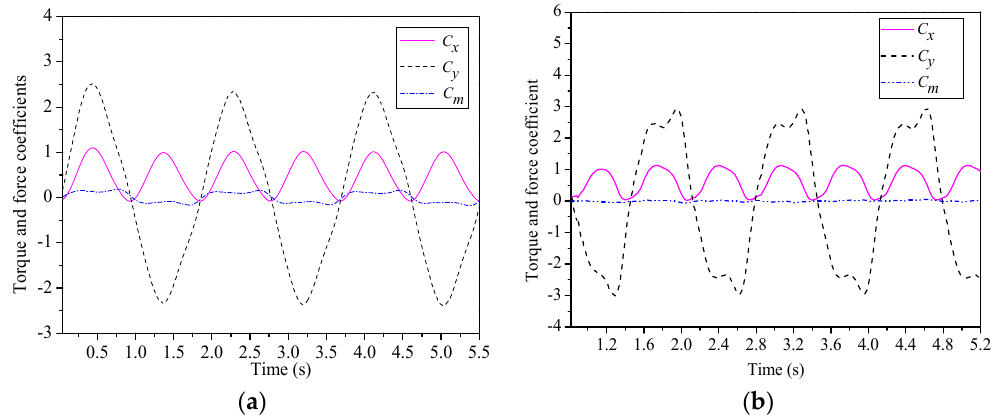
Figure 10. Forces and torque curves: ( a ) NACA foil; ( b ) crescent-shaped foil.